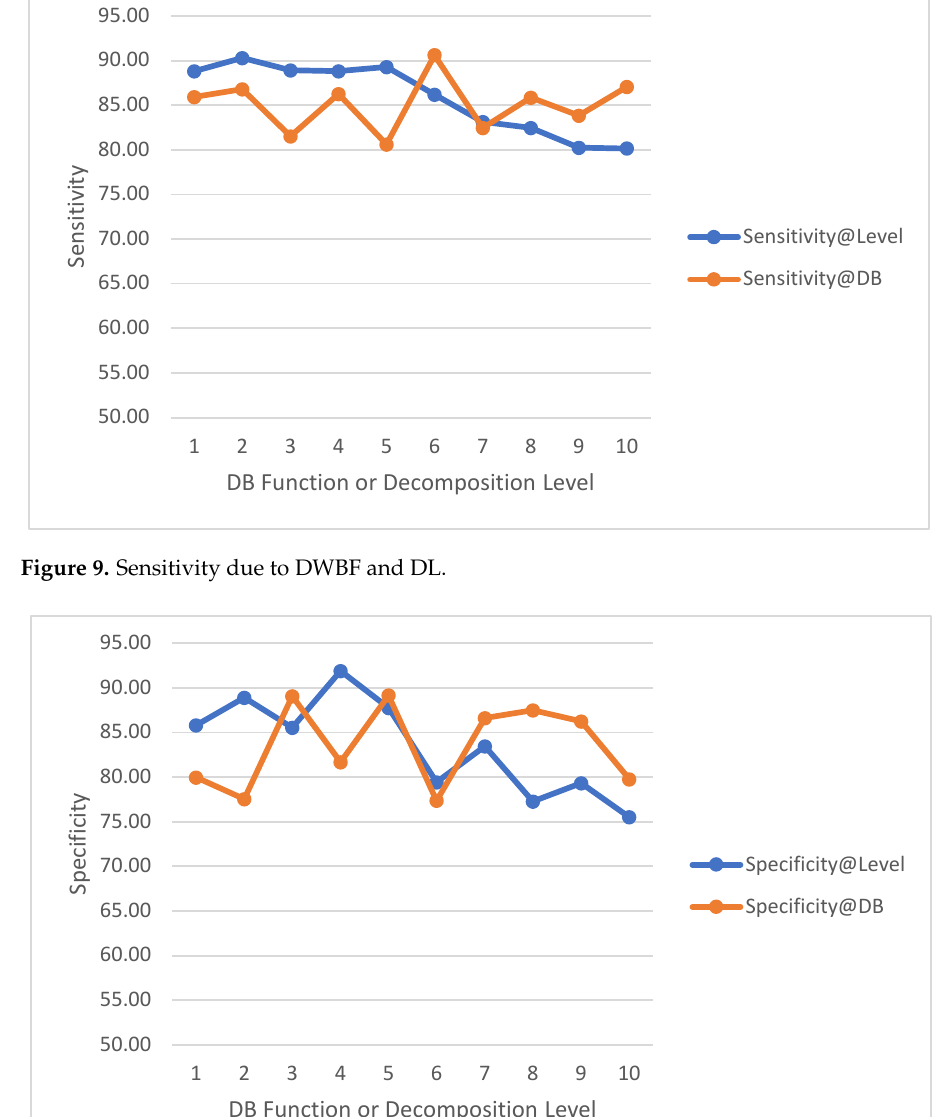
Table 8. Performance of atrial fibrillation detection based on morphological feature extraction algo- rithm of ECG signal using machine learning.